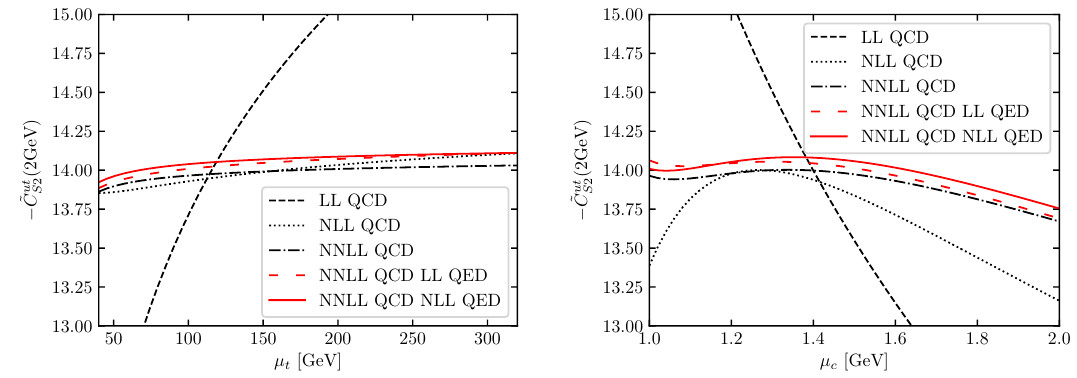
Figure 2 . Residual dependence of the Wilson cofficient ˜ C ut (2 GeV) on the electroweak (left panel) S 2 and charm-threshold (right panel) matching scales. The short-dashed, dotted, and dash-dotted lines show the LL, NLL, and NNLL QCD results, respectively. The long-dashed and solid lines show the results including also the LL and NLL electroweak